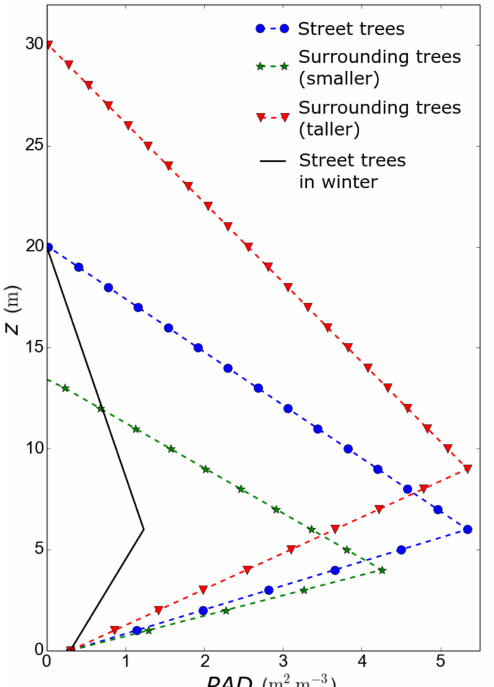
Figure 4. The vertical profile of PAD (m 2 m − 3 ) for the street along the boulevard (blue dashed line with dots). Example profiles for smaller and taller trees outside of the boulevard plotted in green (dashed line with stars) and red (dashed line with triangles), respectively. Additionally, the winter time PAD profile for the street trees is given in black (solid line).